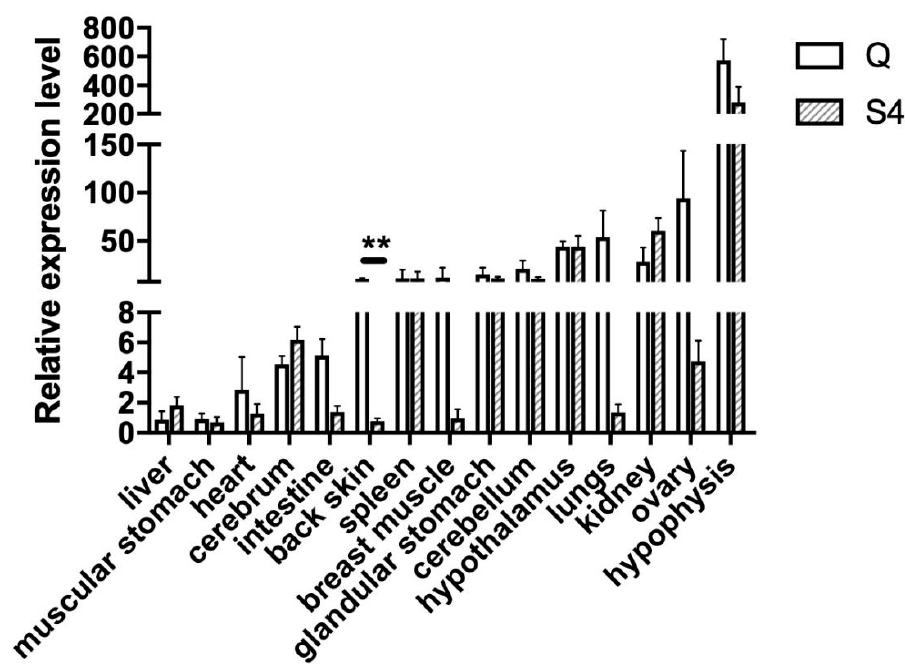
Figure 2. BCO2 expression level in different chicken tissues in the Qingjiao Ma (Q) and Guangxi Huang (S4) chicken breeds. Relative expression analyses in 15 tissue samples of BCO2 gene were normalized to the geometric average of ACTB ( β -actin) and GAPDH genes. Error bars represent the SE, and ** indicates significant differences between different breeds for the same tissue ( p ≤ 0.01).